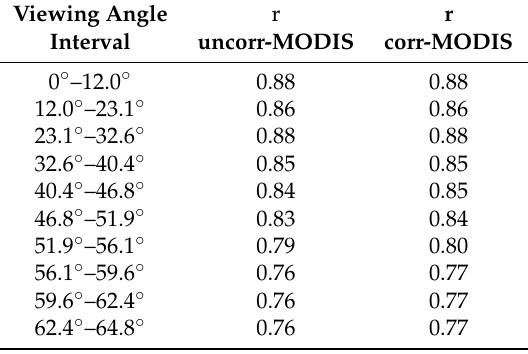
Viewing Angle r r